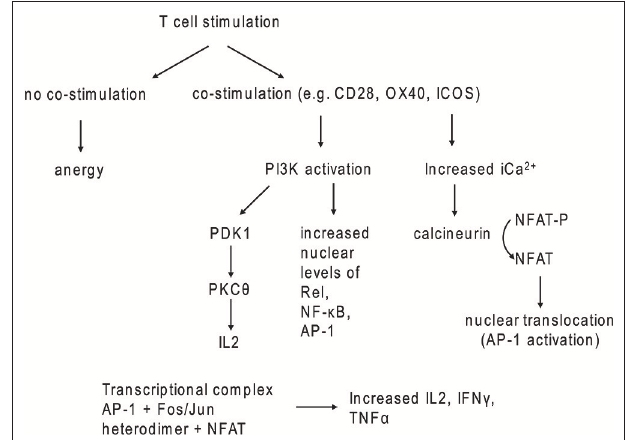
FIGURE 2 | T cell stimulation with and without co-stimulatory signaling. In the absence of co-stimulatory molecules, TCR stimulation leads to